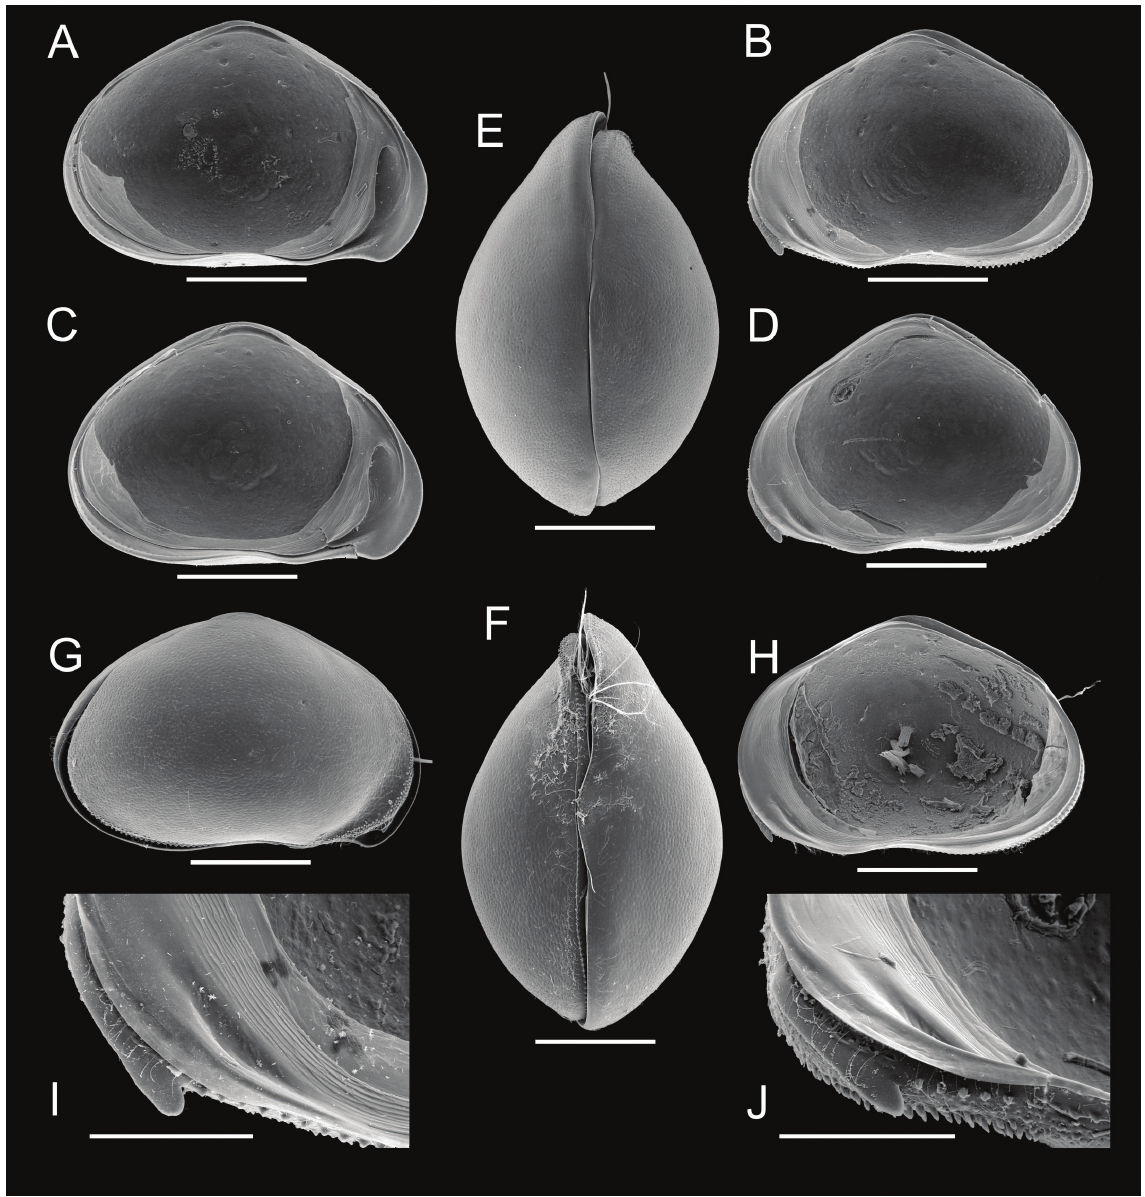
Fig. 5. Bennelongia cygnus sp. nov. A . LVi (♀, Ellen Brook, OC.3311). B . RVi (♀, Ellen Brook, Idem). C . LVi (♂, Ellen Brook, OC.3310). D . LVi (♂, Ellen Brook, Idem). E . Cp dorsal (♀, Goonaping Swamp, WAM.C49378A). F . Cp ventral (♀, Goonaping Swamp, Idem). G . CpRe (♀, Goonaping, WAM. C49378B). H . RVi (♀, Goonaping, WAM.C49377). I . RVi (detail anteriorly, ♀, Ellen Brook, OC.3311). J . RVi (detail anteriorly, ♂, Ellen Brook, OC.3310). Scales: A-H = 500 µm; I-J = 200